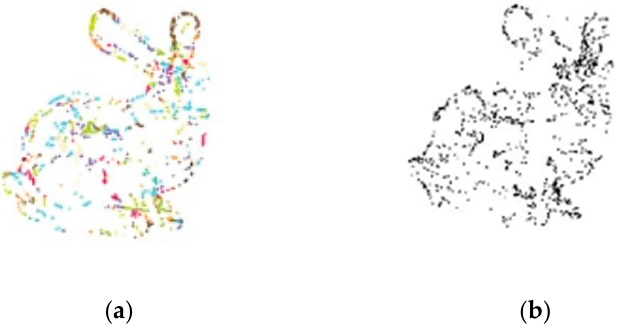
Figure 6. Clusters of boundary points: ( a ) the view of clusters; ( b ) the centers of clusters.